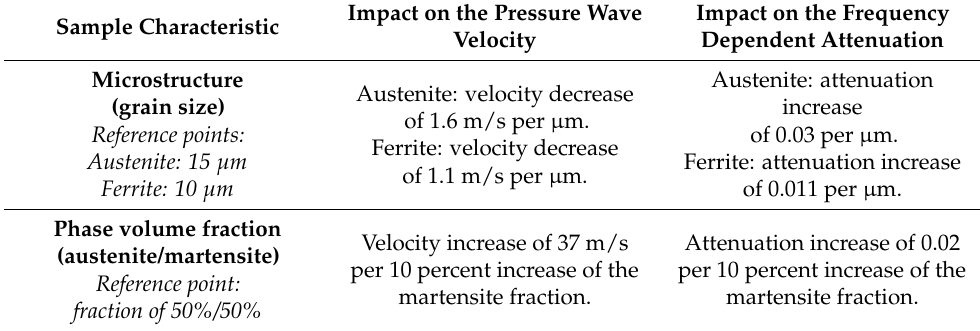
Table 3. An overview of the influence of sample characteristics on measurable